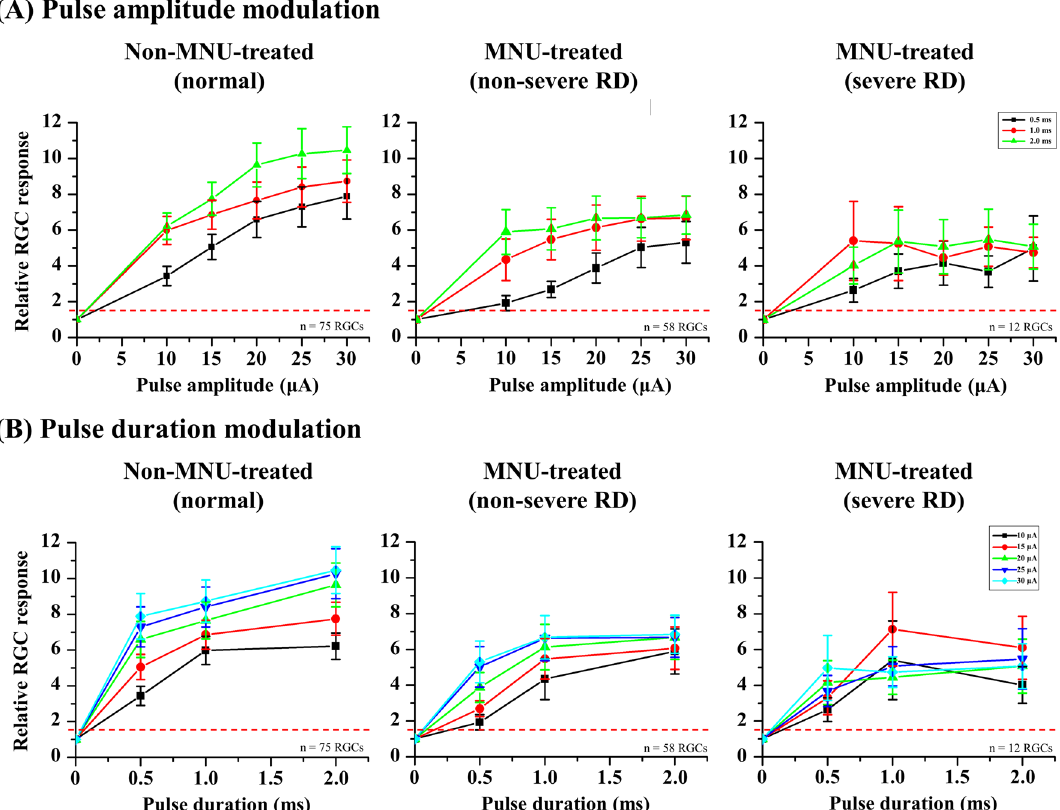
Figure 4. ES-responsiveness of well-modulated RGCs to pulse amplitude modulation (PAM) and pulse duration modulation (PDM). ( A ) Average relative RGC response plotted against pulse amplitude from 0.5 to 2 ms fixed duration for non-MNU - treated (left), MNU - treated non-severe RD (middle), and MNU - treated severe RD (right) groups. Error bars represent the SEM. The threshold level is plotted as red dashed line at 1.5 times. ( B ) Mean evoked RGC spike number plotted against pulse duration from 10 to 30 μA fixed